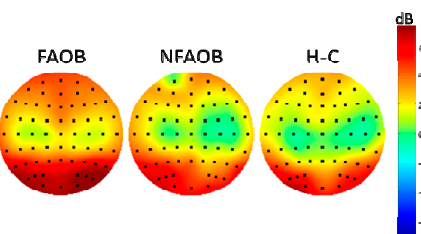
Figure A3. Topographical power maps of the raw resting state EEG activity. Topographical maps of the average resting state power in the experimental groups. No group di ff erences were found using a nonparametric F test in any of the